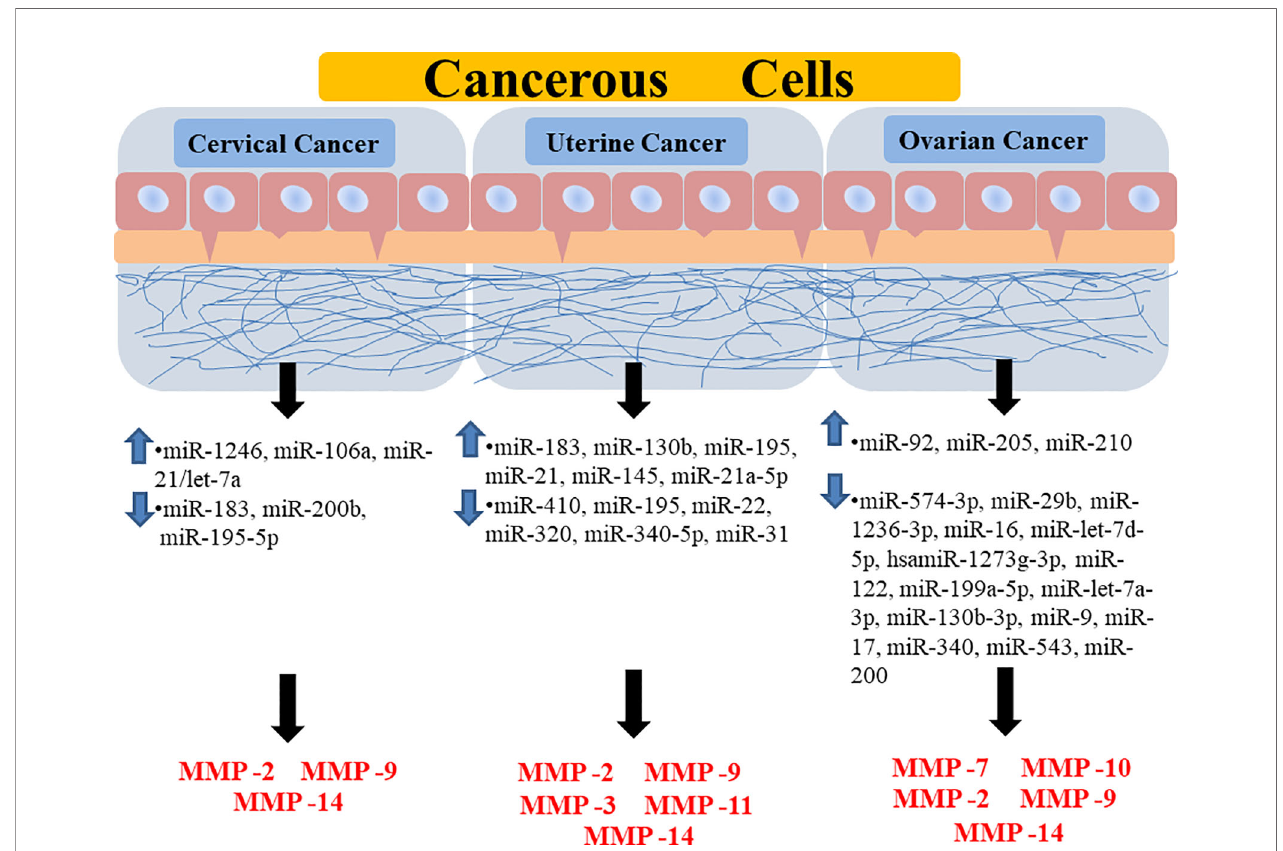
FIGURE 4 | Diagrammatic representation showing the regulation of different MMPs through different miRNAs in various forms of gynecological cancer. It is showing how the upregulation or downregulation of certain miRNAs is promoting the expression of certain MMPs in a speci fi c type of gynecological cancer. Highlighted miRNAs are highly correlated to major signaling pathways and target MMP-9/2 activities. MMP, Matrix Metalloprotease; miR,